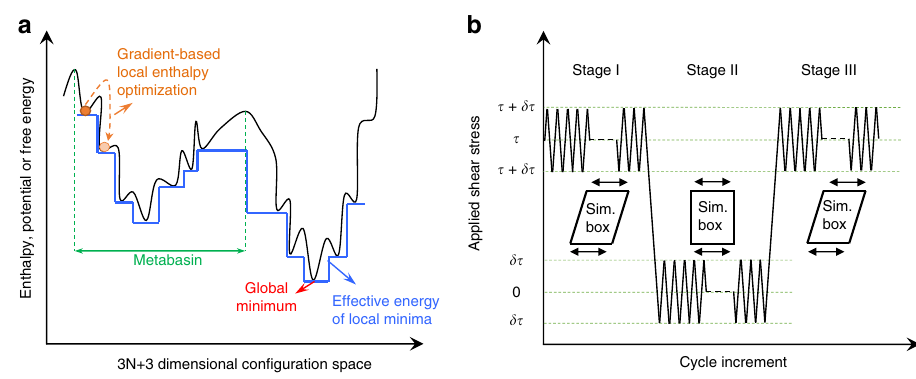
Fig. 1 Exploring the energy landscape via the incremental stress marching approach. a A schematic representation of the energy landscape for a complex system. The orange ball represents the initial state of the system. Applying an external stress and local enthalpy minimization can help overcome the energy barrier, which ultimately takes the system to the minimum of the metabasin. We note that this method would not take the system to an adjacent metabasin that contains the global minimum. b Schematic representation of incremental cyclic scheme proposed in this study. The approach contains loading, unloading and reloading sequences, which are demonstrated from left to right. The stress is incrementally perturbed around a mean shear